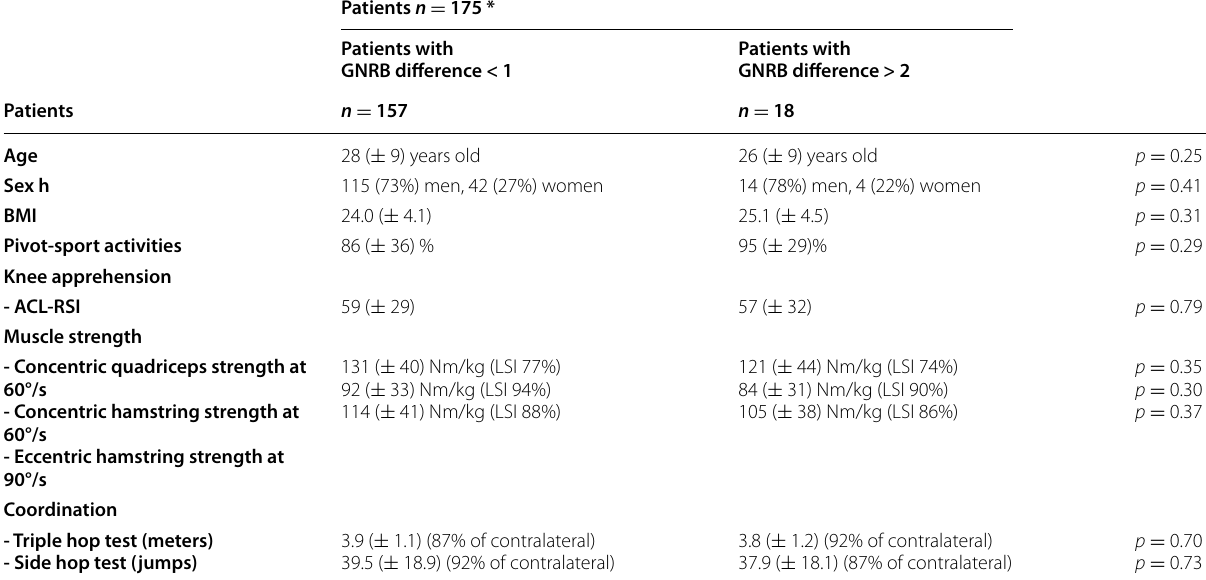
* Exclusion of 128 patients who had intermediate GNRB difference between 1 and 2 mm BMI Body mass index , ACL-RSI Anterior cruciate ligament return to sport after injury, LSI Limb symetry index